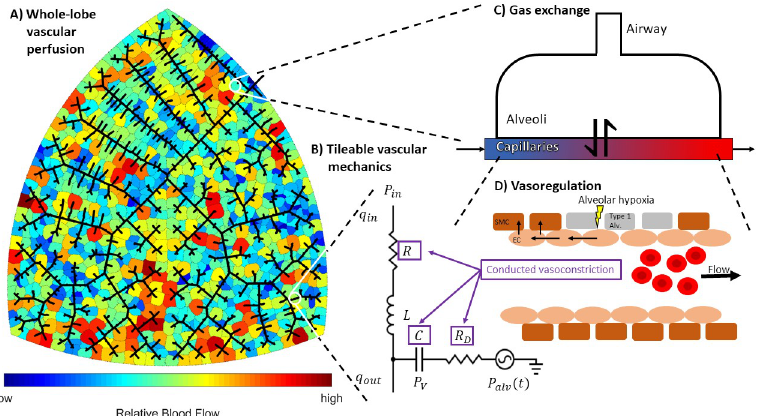
Fig 1. Schematic of our multi-scale multi-physics model of ventilation-perfusion matching. Block (A) illustrates the whole-lobe vascular network model. Black lines represent blood vessels, and colored regions represent discrete zones of perfusion. The network geometry is agnostically generated by a space-filling algorithm inspired by Wang et al. [33]. Block (B) shows how the mechanics of each vessel segment is represented as an equivalent circuit. Intravascular pressure ( P v ) and flow into the vessel ( q in ) are the state variables; inlet pressure ( P in ) and flow out of the vessel ( q out ) are the initial conditions at boundaries for a given vessel segment; outlet pressure ( P ) is an algebraic constraint; time- out varying alveolar pressure ( P alv ) is a dynamic pressure source; and hydraulic resistance ( R ), inertance ( L ), compliance ) are anatomical parameters calculated from the geometry of the vessel segment ( C ), and vessel wall resistance ( R D (length and radius) and can be modulated by vasoregulation (purple boxes). Block (C) depicts a representative gas exchange unit. Gases flowing through the capillary tube are exchanged with an alveolar compartment. Block (D) portrays the oxygen-sensitive vasoregulatory mechanism hypoxic pulmonary vasoconstriction (HPV). Hypoxia in the alveolar space induces conducted vasoconstriction. Conducted vascular responses are spatially propagated in a upstream through the endothelium—these responses modulate the values of the anatomical parameters ( R , C , and R ) D in the arterial network.